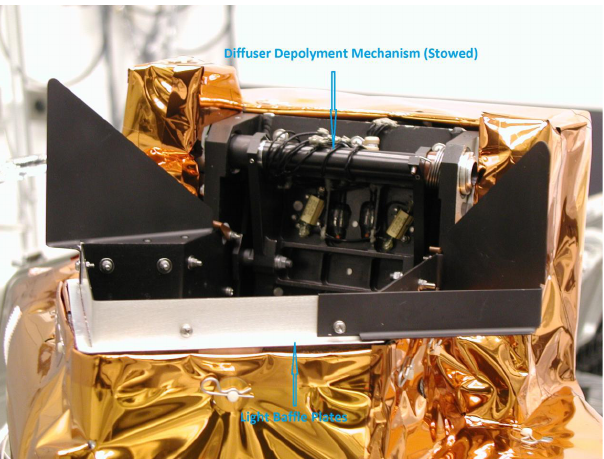
Fig. 5. Initial profile albedo residue (IPAR) comparison between NOAA-19 and NOAA-17 in the Northern Hemisphere, where N19 is contaminated with IBSL and N17 is clean. The comparison is made at the same latitude band of 0.5 ◦ on a weekly average. The difference is plotted against N19’s spacecraft centered solar elevation angle (SCSEA). Under normal satellite attitude conditions, the SC- SEA is equal to SZA − 90 ◦ . Therefore, these figures cover the dayside from SZA = 70 ◦ to SZA = 90 ◦ . Standard errors in the average are plotted as error bars. IPAR differences, weighted with 1/error 2 , are fitted separately with two straight lines at SCSEA ≥− 10 ◦ and SCESA ≤ − 15 ◦ , shown with solid, thick black lines. The fitted IPAR is subtracted with the background at − 15 ◦ , shown in red.